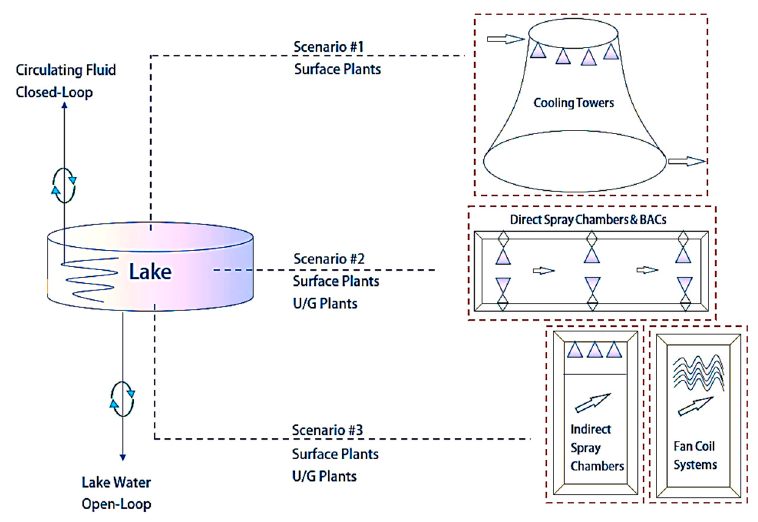
Figure 1. Deep lake water utilization scheme (not to scale).